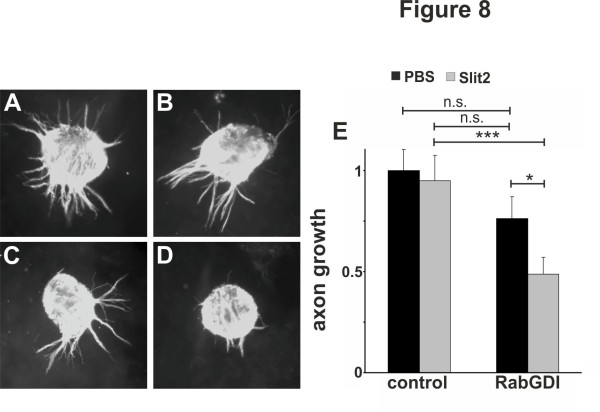
Pre-crossing commissural axons become sensitive to Slit2 by premature RabGDI expression. Explants containing young mock-transfected commissural neurons readily extend axons, which correspond to pre-crossing commissural axons, when cultured in a 3D collagen gel (A). The addition of recombinant Slit2 does not affect axon growth from these explants (B). A slight, but not significant reduction in axon growth was observed when explants were taken from embryos expressing RabGDI prematurely at HH21/22 (see Material and Methods and text for details; C,E). However, a strong reduction in axon growth was observed when RabGDI-expressing ‘pre-crossing’ commissural axons were cultured in the presence of Slit2 (D,E). Axons were visualized with anti-neurofilament staining. For quantification of axon growth 20–25 explants per condition were used. Axon length of mock-transfected neurons was set to 1.0 (E). Axon length from mock-transfected neurons was not different in the presence of Slit2 (0.95 ± 0.12; p = 0.765). In the absence of Slit2, commissural neurons expressing RabGDI extended axons that were slightly, but not significantly shorter than mock-transfected neurons (0.76 ± 0.11; p = 0.121). In the presence of Slit2, axon length was significantly shorter when neurons expressed RabGDI prematurely (0.49 ± 0.08; p = 0.0028 compared to mock-transfected neurons in the presence of Slit2 and p = 0.048 compared to RabGDI-expressing axons in the absence of Slit).